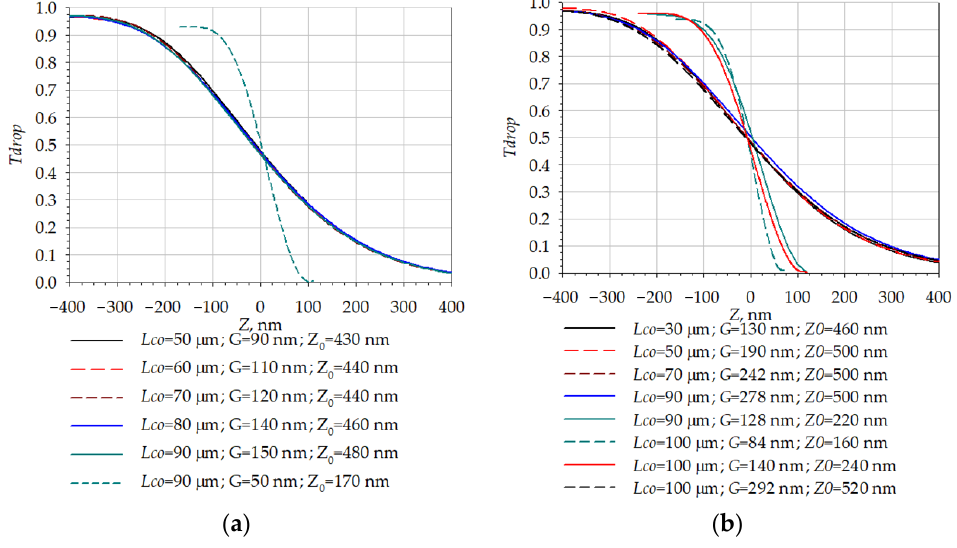
Figure 18. Dependencies of the optical transmission coefficient on the inertial mass linear displace- ment along axis Z for the OMT with single-plane waveguides (Scheme 3). ( a ) Waveguides with dimensions of 300 × 1000 nm; ( b ) Waveguides with dimensions of 300 × 750 nm.